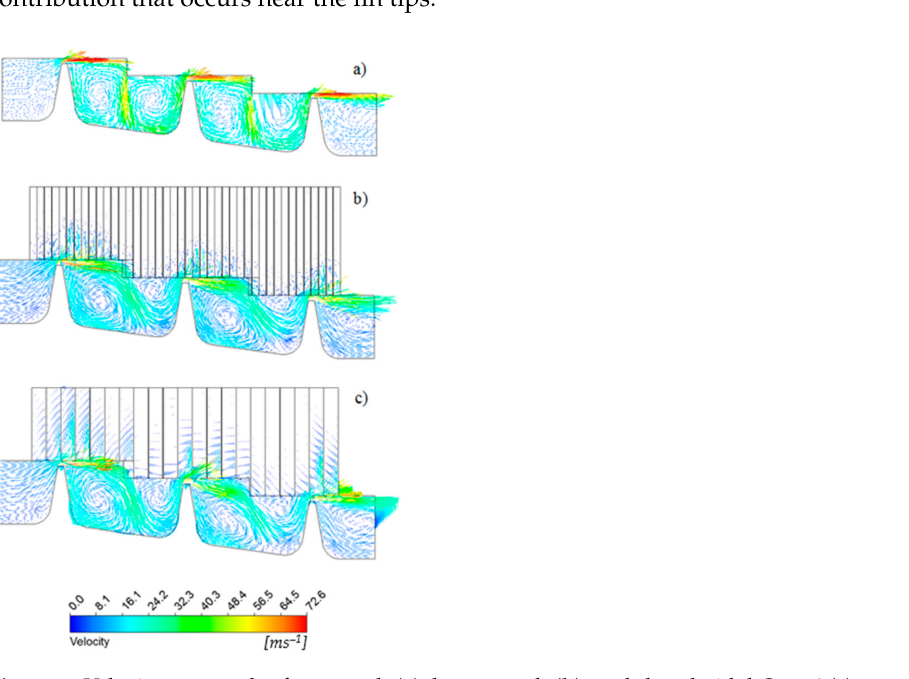
Figure 8. Velocity vector plot for smooth ( a ), honeycomb ( b ), and rhomboidal C R = 4 ( c